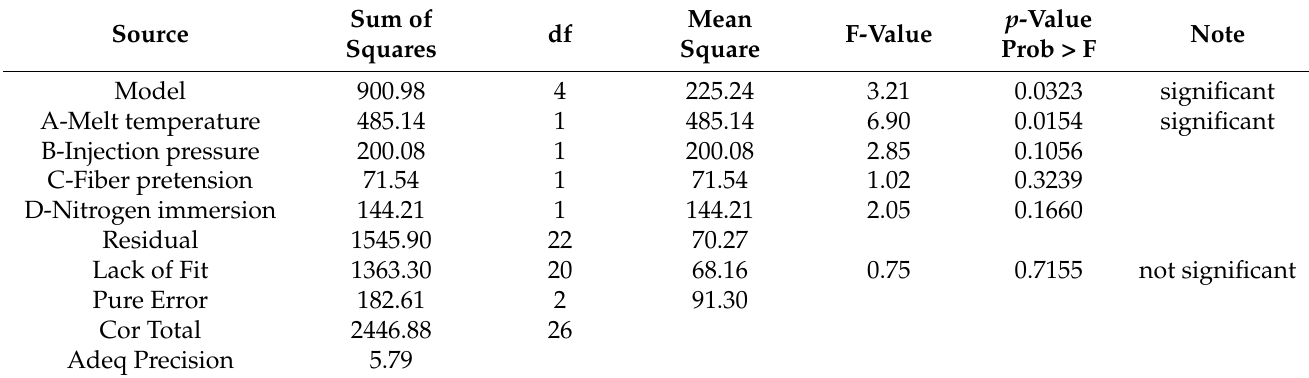
Table 6. ANOVA for flexural